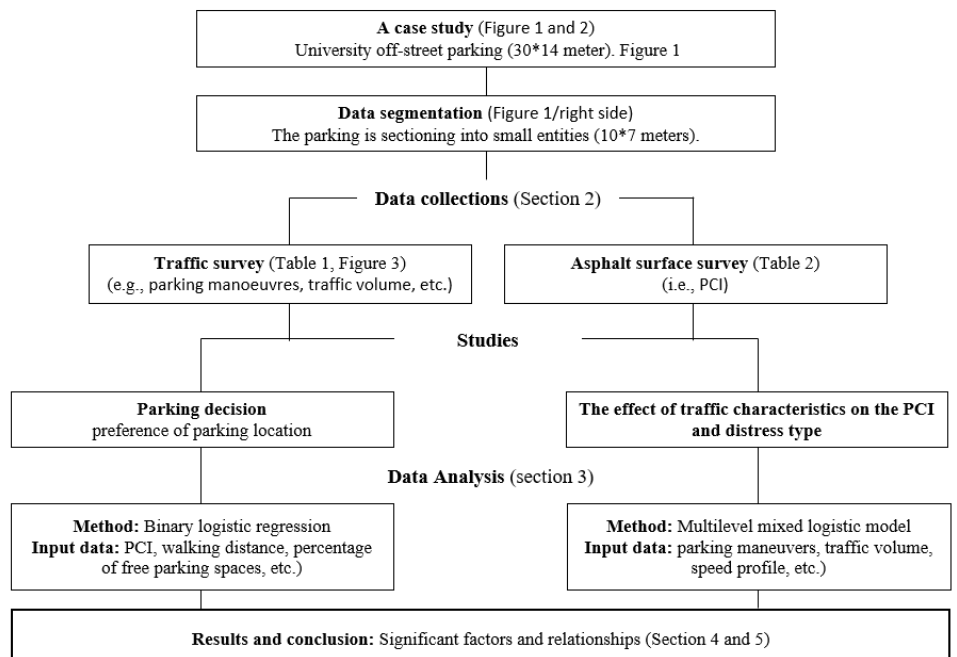
Figure 4. A schematic diagram of the applied methodology.